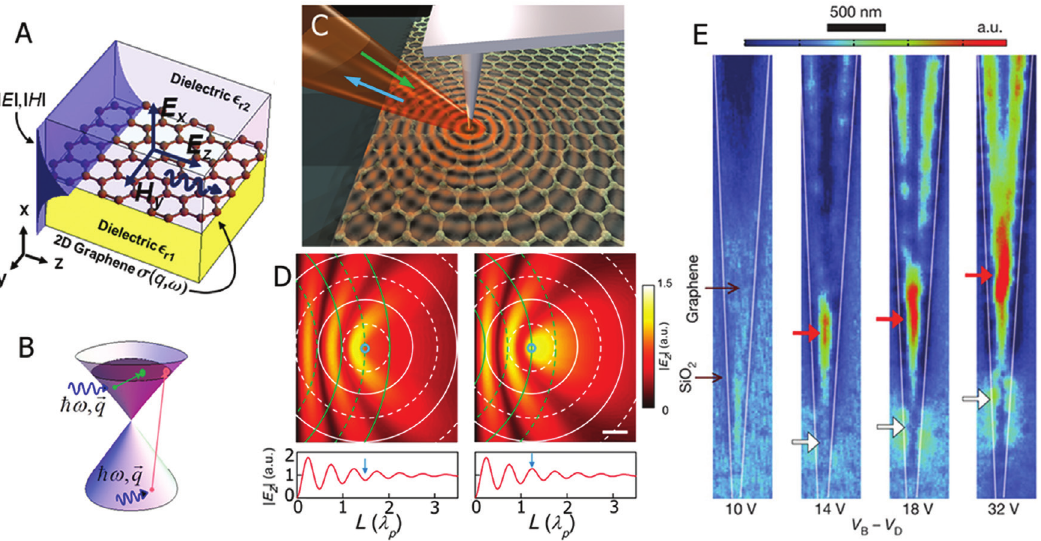
Figure 7 (A) Schematic of SPPs in graphene. (B) Electronic band structure of graphene. The green and pink arrows represent the intra- and interband transitions, respectively. (C) Schematic of the experimental configuration to launch and detect SPPs on graphene based on near-field scanning optical microscopy (NSOM). A sharp metallic tip illuminated by an infrared laser is used to locally excite SPPs, and the near-field SPP signal can be scattered by the tip into the far-field and detected. (D) Top panels show the snapshots of destructive (left) and constructive (right) interference of plasmon waves underneath the tip (blue circles). The bottom panels are the profiles of electric field amplitude underneath the tip versus its distance to the left edge. The scale bar is half wavelength of SPPs. (E) Near-field amplitude images showing the switching of graphene plasmons when a backgate voltage is applied. Red and white arrows denote the positions of resonant local plasmon modes on a tapered graphene ribbon. (A) and (B) are adopted from Ref. [123], (C) and (D) are adopted from Ref. [135], and (E) is adopted from Ref. [136] with